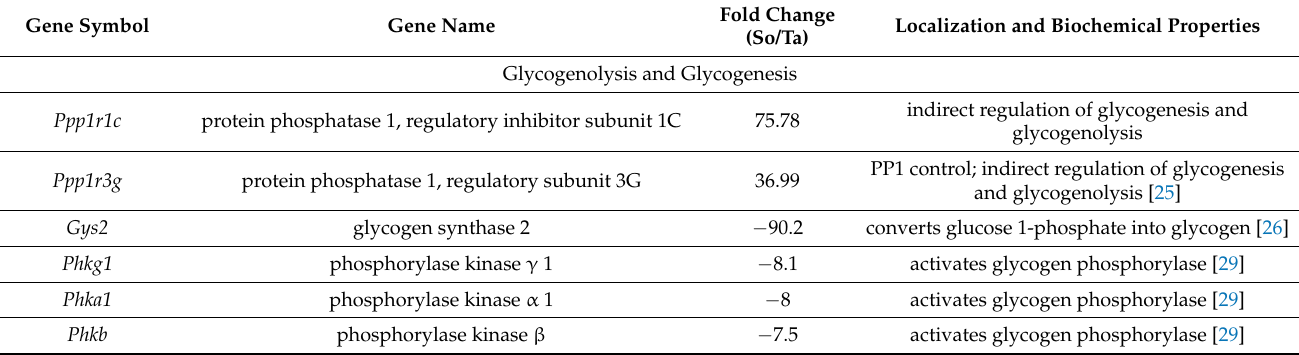
Table 2. Differentially expressed genes associated with glucose and glycogen metabolic